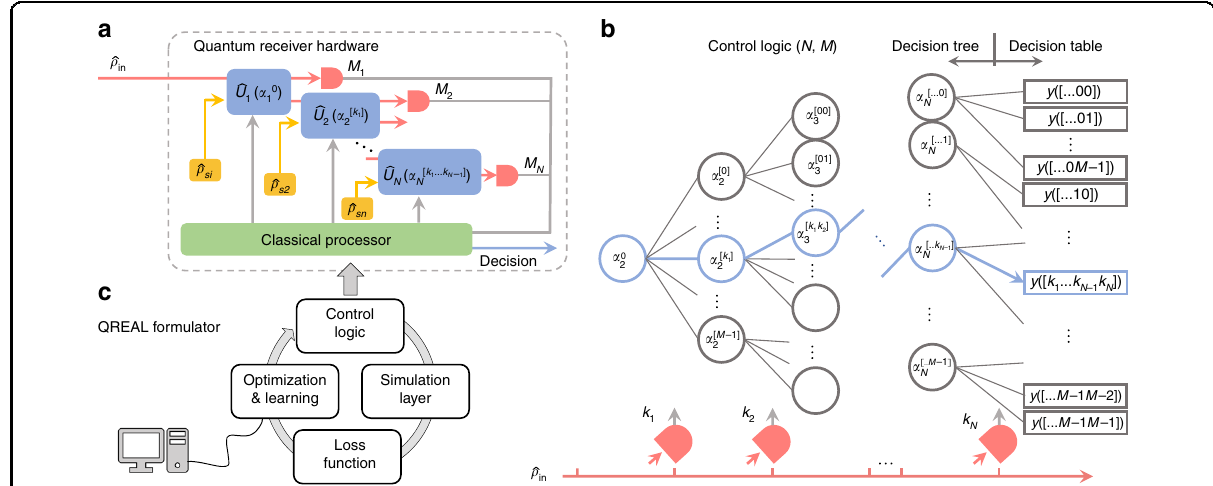
Fig. 1 Overview on the QREAL architecture. a The hardware of a general quantum receiver composed of rounds of processing. The j th processing round entails a variational quantum circuit represented by the unitary operation ^ U j con fi gured by the parameter set α j , ancillary states ^ ρ measurement apparatus M j . b The control logic comprised of a decision tree and a decision table. Blue lines show one possible path toward the output. Quantum-receiver output y is determined by the sequence of measurement outcomes, tied to a unique path in the decision tree. c The QREAL formulator consisting of four modules (clockwise) as one iteration in the learning process. The control logic optimized by the